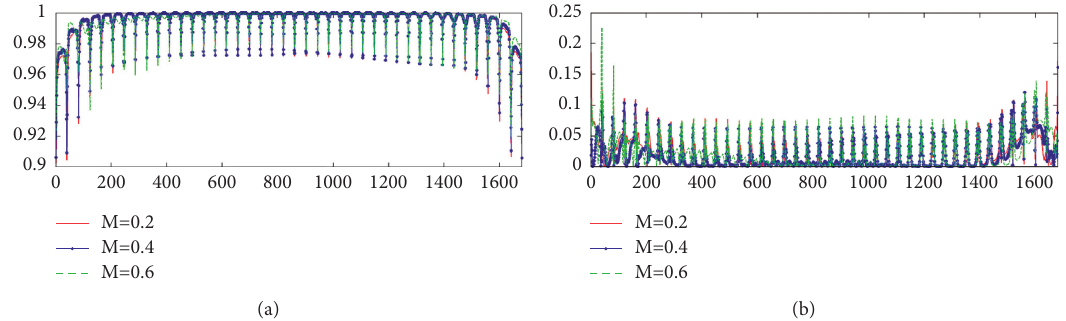
Figure 10: The temporal indicators T 1 (a) and T 2 (b) to assess the phase and the amplitude similarities between the calculated time signals and the theoretical time signals on plane z r � 0.2m at different Mach